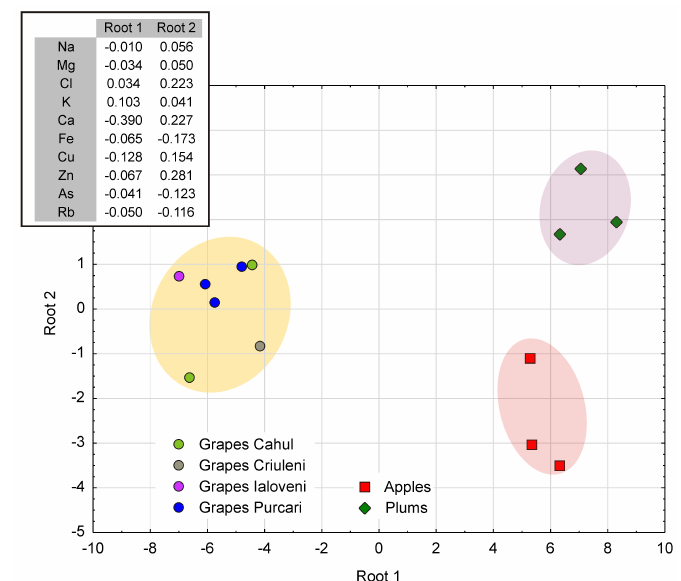
Figure 4. The result of discriminant analysis illustrating the existence of three clusters, each of them consisting of a single type of